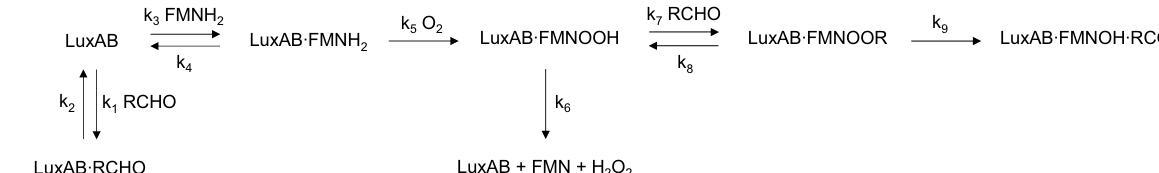
Figure 1. Reaction scheme of the bacterial bioluminescence reaction. LuxAB: luciferase, RCHO: fatty aldehyde, RCOOH: fatty acid, FMN: flavin mononucleotide, FMNH 2 : reduced FMN, O 2 : molecular oxygen, H 2 O 2 : hydrogen peroxide, FMNOOH: C4a-peroxy-FMN, FMNOOR: FMN-C4a-peroxyhemiacetal, FMNOH: C4a-